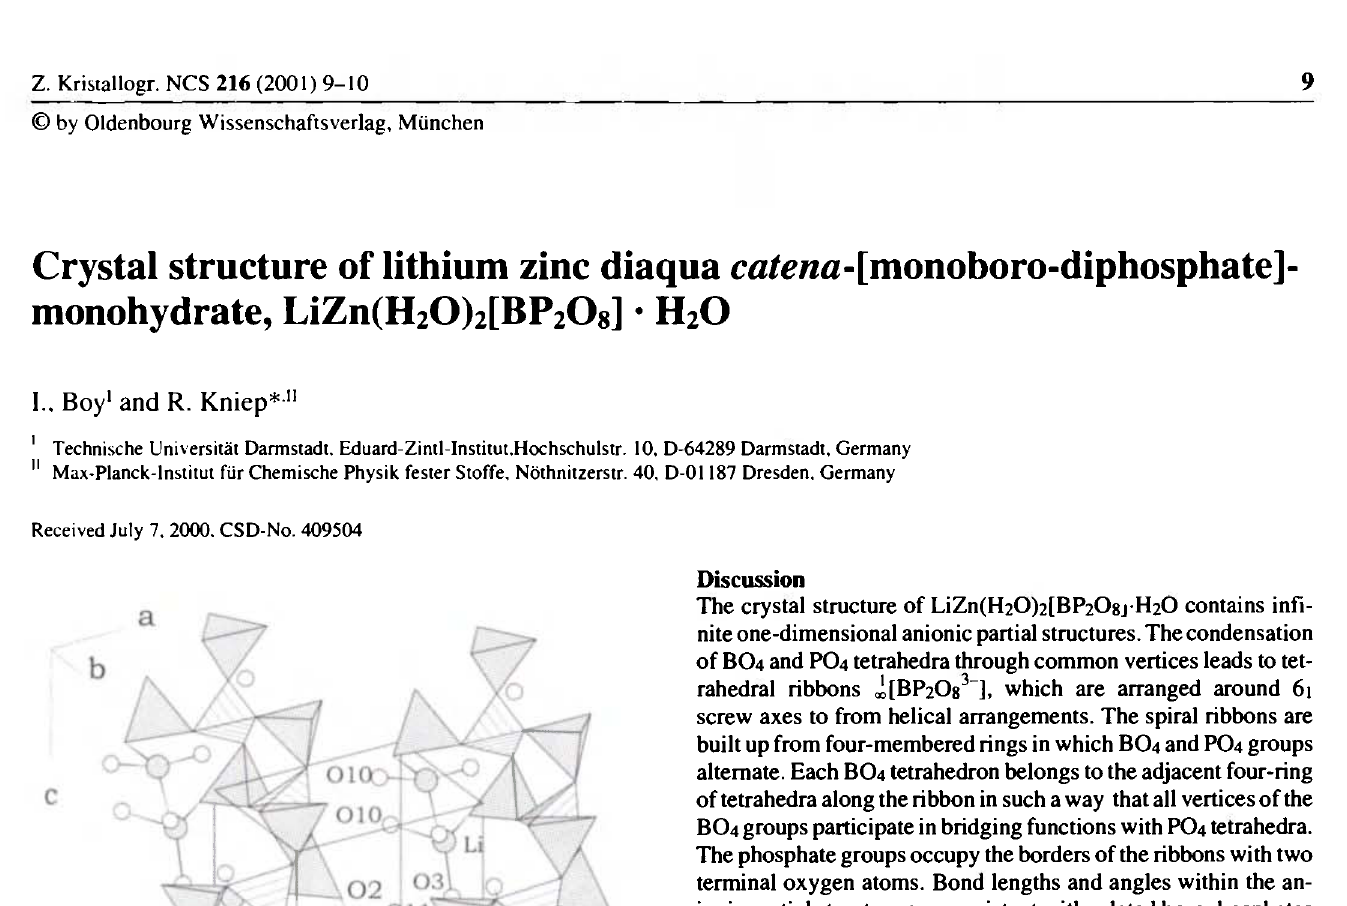
Table 1. Data collection and handling.